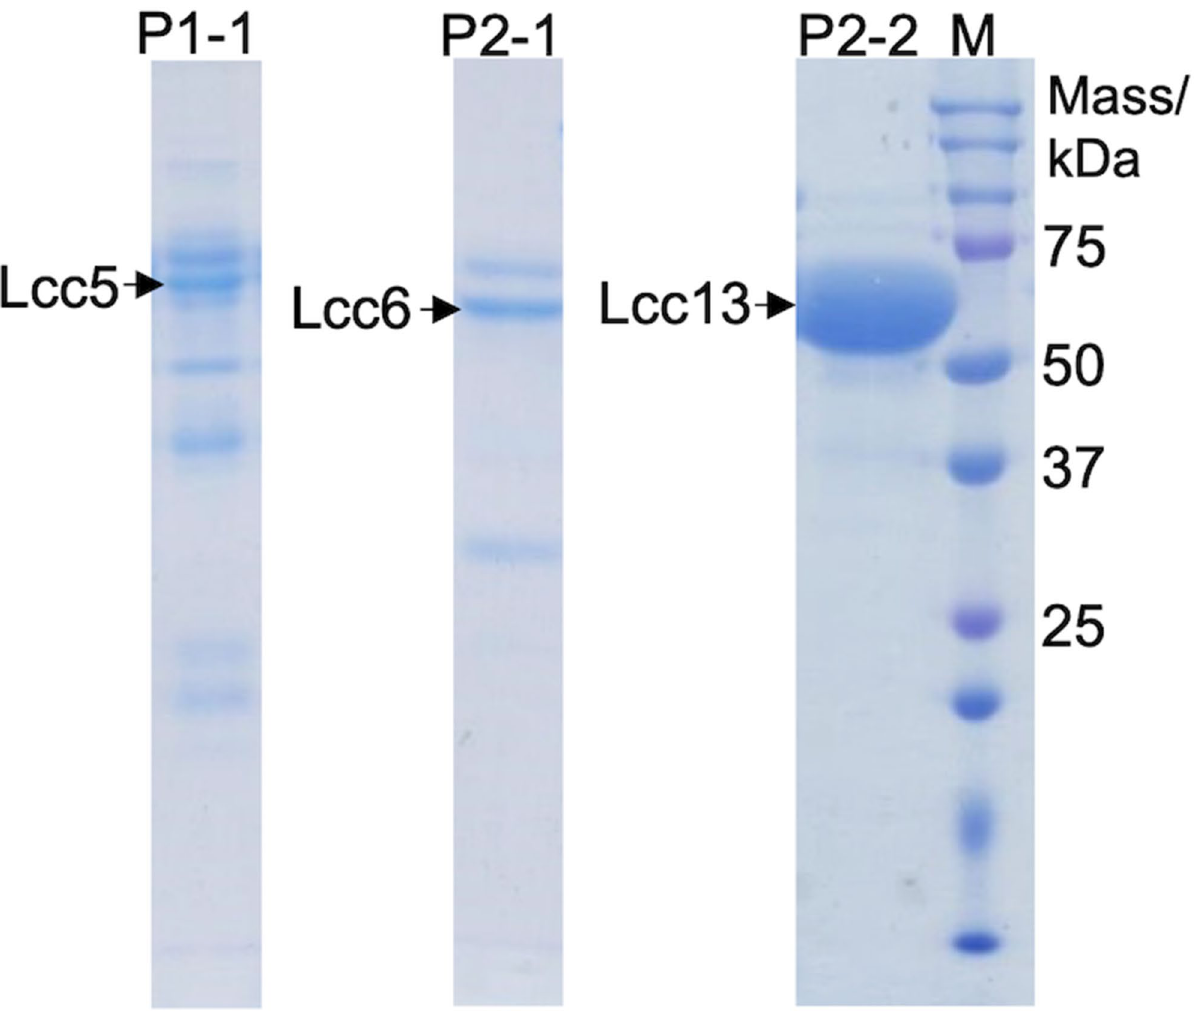
Fig. 4 SDS-PAGE pattern of the partially purified Lccs. The proteins with Lcc activity were purified from extracts of the bottom part of the cultured saw- dust medium. The obtained active fractions, P1-1, P2-1, and P2-2, were applied to SDS-PAGE. The obtained bands were applied to LC-MS/MS analysis, and three Lccs, Lcc5 (molecular mass of 68 kDa, from P1-1), Lcc6 (55 kDa, from P2-1), and Lcc13 (61 kDa, from P2-2), were